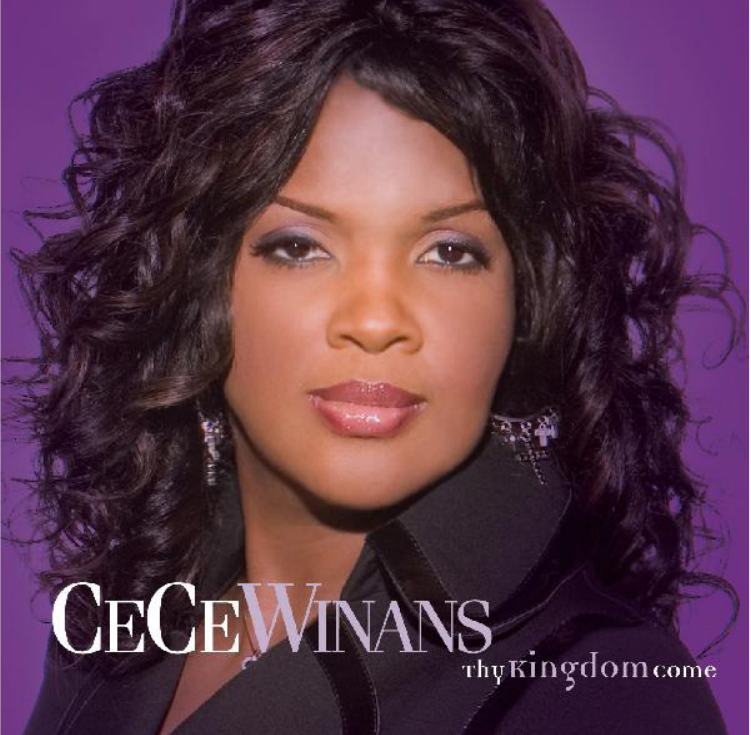
Figure 1. Cover of Thy Kingdom Come